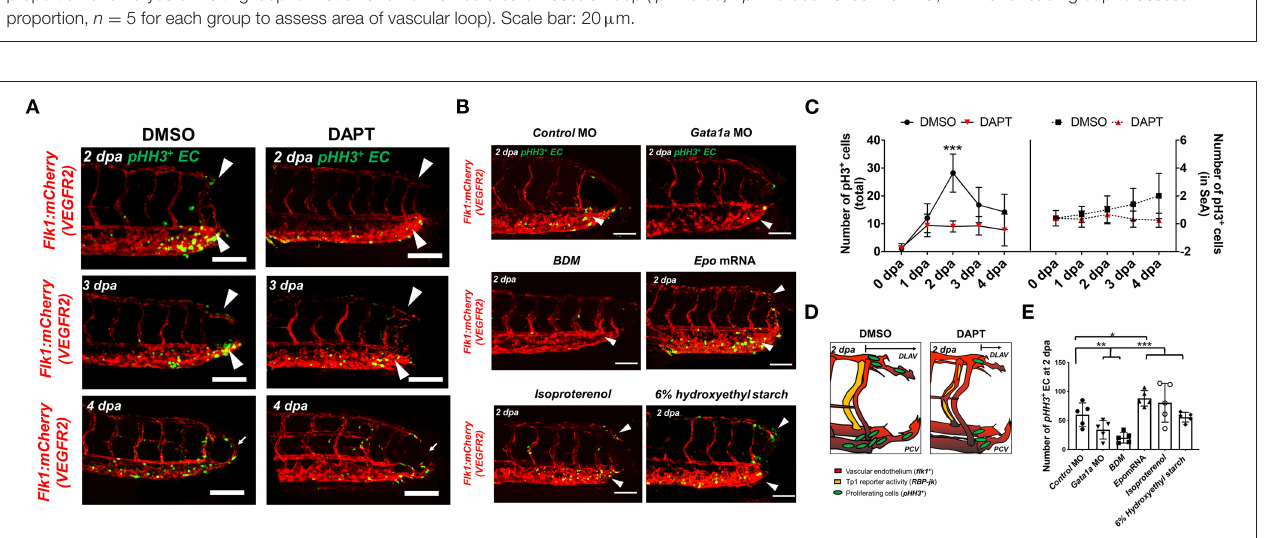
FIGURE 3 | Amputation-mediated Notch signaling regulates EC proliferation in the DLAV and CVP during vascular loop formation. (A) DAPT treatment to inhibit Notch activity significantly reduced the number of EC proliferation ( pHH3 + EC, green) compared to DMSO-treated controls at 2 dpa (white arrowheads). Scale bar: 20 µ m. (B) Gata1a MO injection or BDM treatment reduced, whereas epo mRNA and isoproterenol treatment increased pHH3 + EC at 2 dpa. ( * p < 0.05 , ** p < 0.005, *** p < 0.0005 vs. control MO, n = 5 for each group). Scale bar: 20 µ m. (C) Total numbers of endothelial pHH3 + EC in posterior tail segment and the caudal SeA were assessed to quantify Notch-dependent proliferation. 2 days of DAPT treatment resulted ∼ 48% reduction in total number of pHH3 + EC, but not in the caudal SeA ( ** p < 0.005 vs. DMSO, n = 3 for DMSO, n = 5 per other groups). (D) Schematic representation of Notch-mediated pHH3 + EC during vascular loop formation. (E) Total pHH3 + EC in posterior tail were assessed to quantify WSS-dependent EC proliferation. Gata1a MO injection or BDM treatment reduced ∼ 42 and ∼ 65%, whereas epo mRNA and isoproterenol treatment increased pHH3 + EC by ∼ 52 and ∼ 39% respectively at 2 dpa. ( * p < 0.05 , ** p < 0.005, *** p < 0.0005 vs. control MO, n = 5 for each group). Scale bar: 20 µ